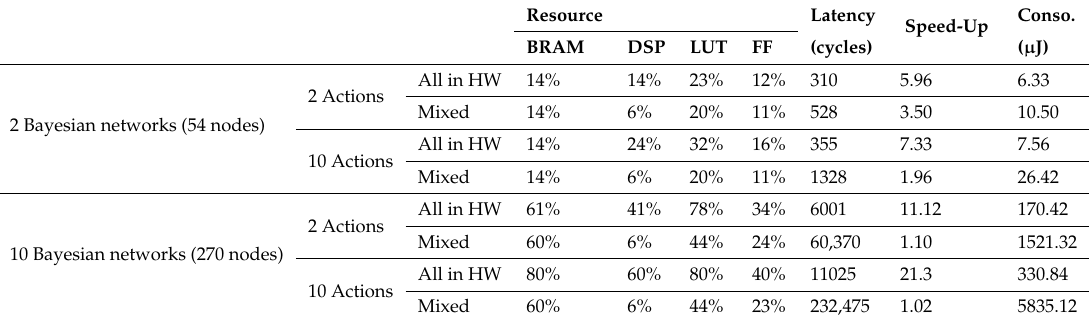
Table 7. Resource and performance of the DN implementation by varying the number of Bayesian networks and actions.